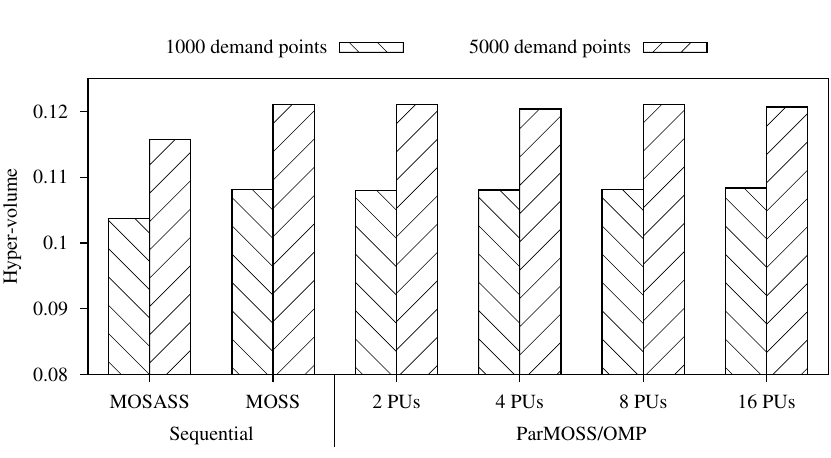
Figure 7. Average values of hyper-volume, obtained by sequential MOSASS and MOSS and parallel shared-memory MOSS (ParMOSS/OMP) using different numbers of processing units.